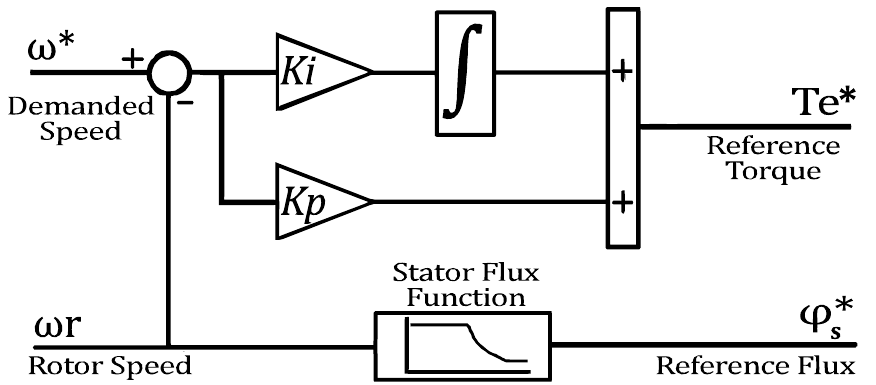
Figure 4. The structure of a PI speed controller for a DTC drive.